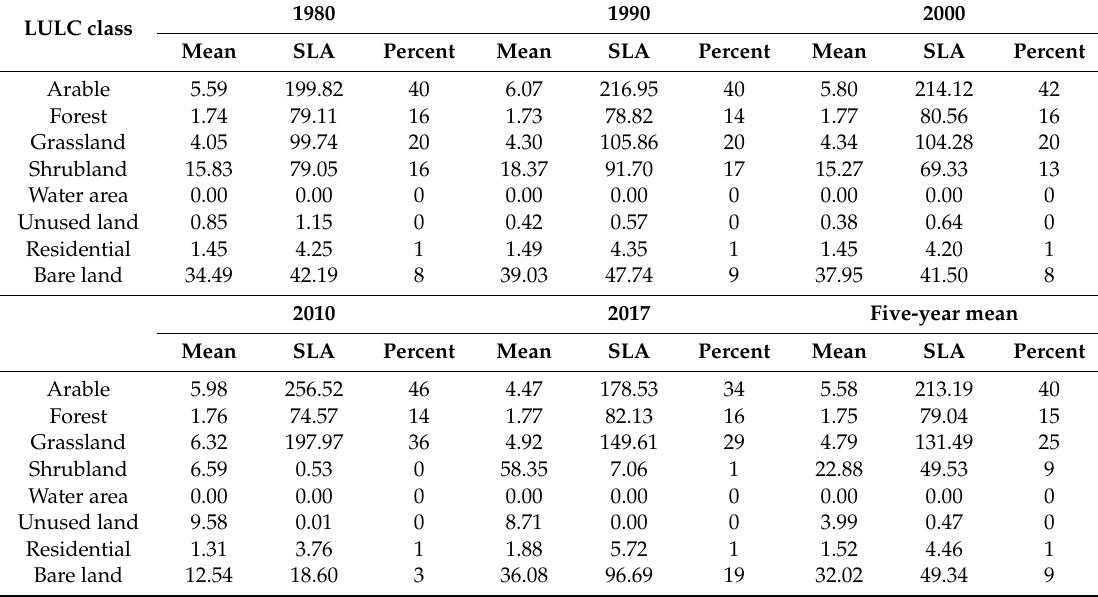
Table 4. The mean soil erosion rate (Mg ha − 1 yr − 1 ), soil loss amount (SLA; 10 6 Mg), and their percentage (%) of the total as well as their mean values of the five years for each land use